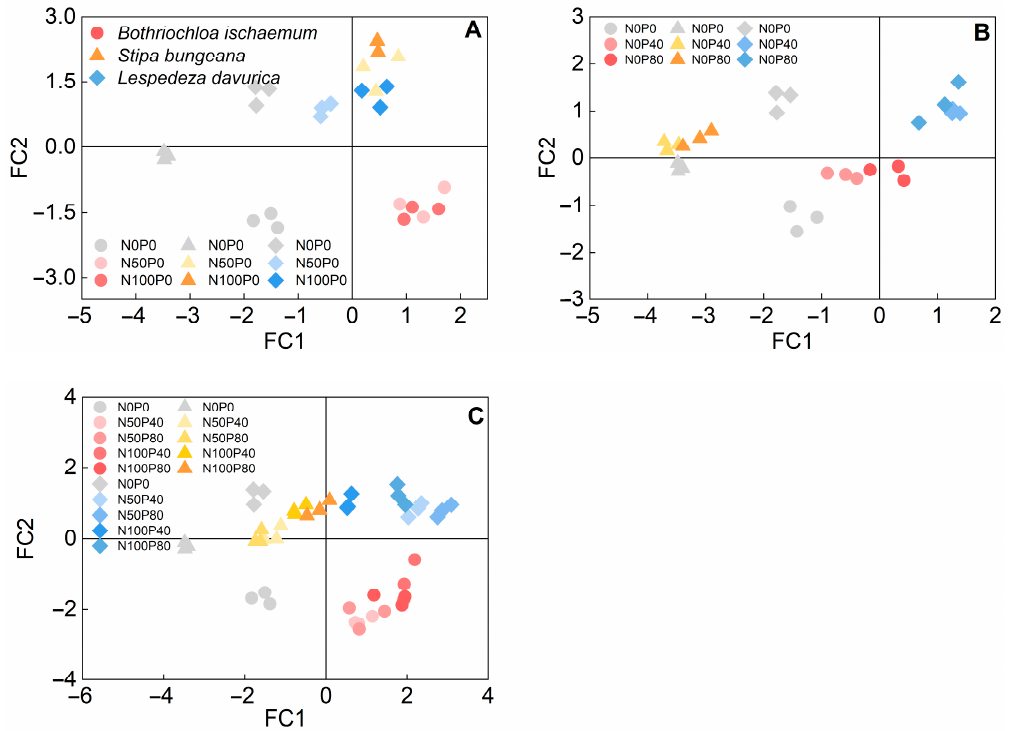
Figure 9. Score plots of PCA analysis of photosynthetic characteristics ( P Nmax and WUE) and leaf economic traits (SPAD, N mass , P mass , SLA, and LDMC) in the three species under N and P additions. ( A ) N addition alone; ( B ) P addition alone; ( C ) N and P combined addition.